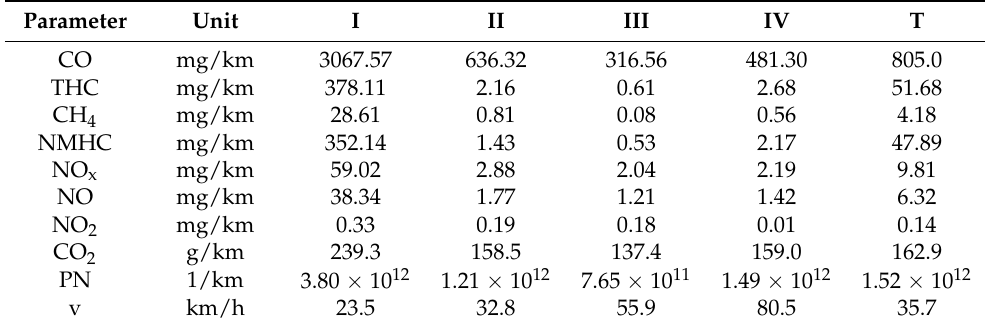
Table 2. Mean road emissions, mean road number of emitted particles and average vehicle speed from the individual test phases and from the entire WLTC test.